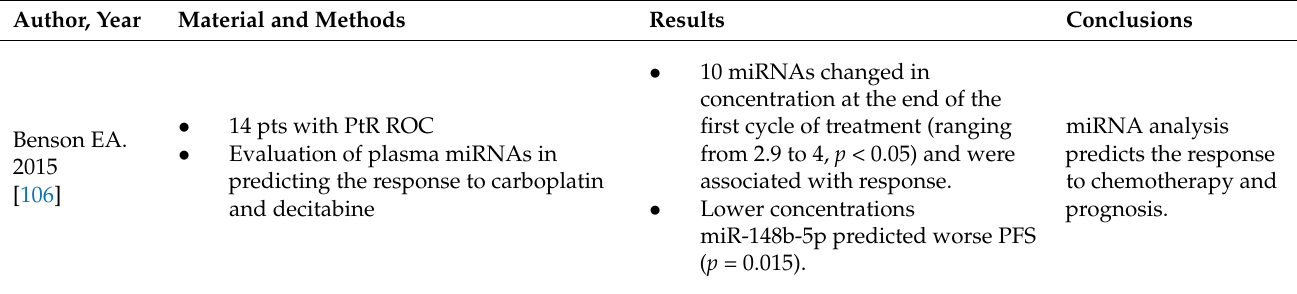
Table 4. Most relevant evidence about the potential value of miRNA in PtR